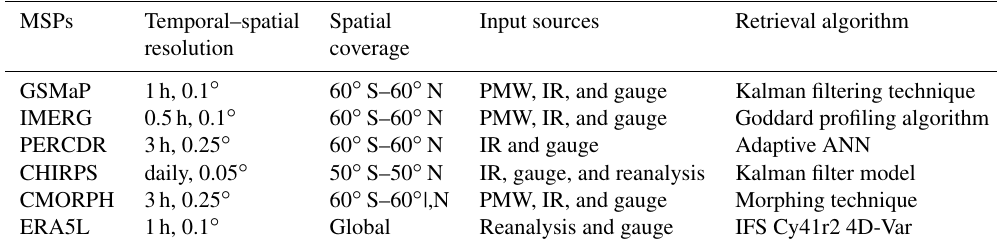
Table 1. The seven MSPs used in this